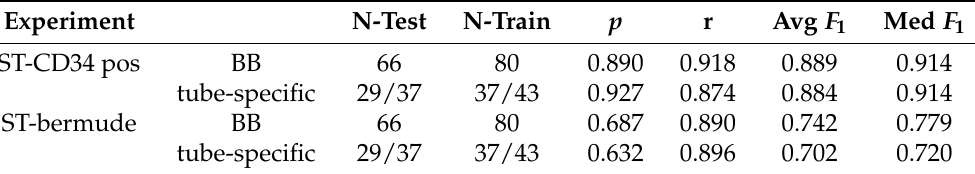
Table 5. Results of predicting CD34 positive events and those in the bermude area (CD34 neg) with the Set-Transformer (ST). For tube-specific results, using the 8-color LAIP and CFU (+drop-ins) panels the number of test and training samples are given separately. 20% of the training data are used for